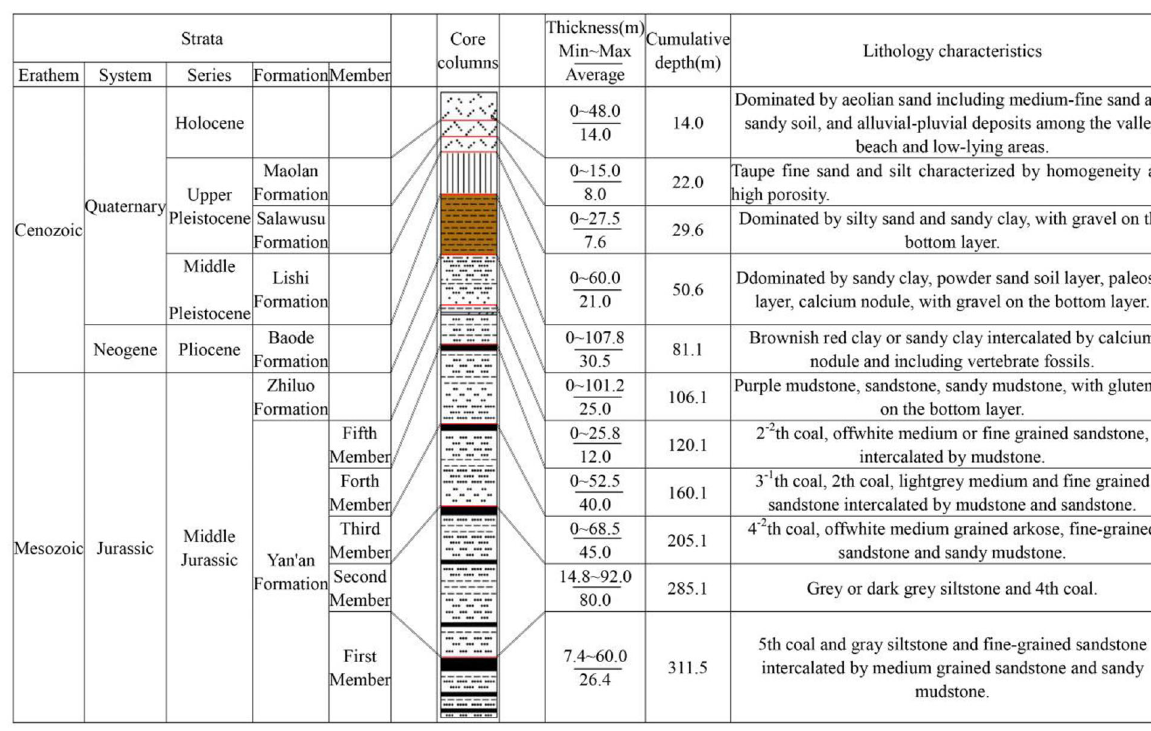
Fig. 2 Comprehensive typical strata column for western coal